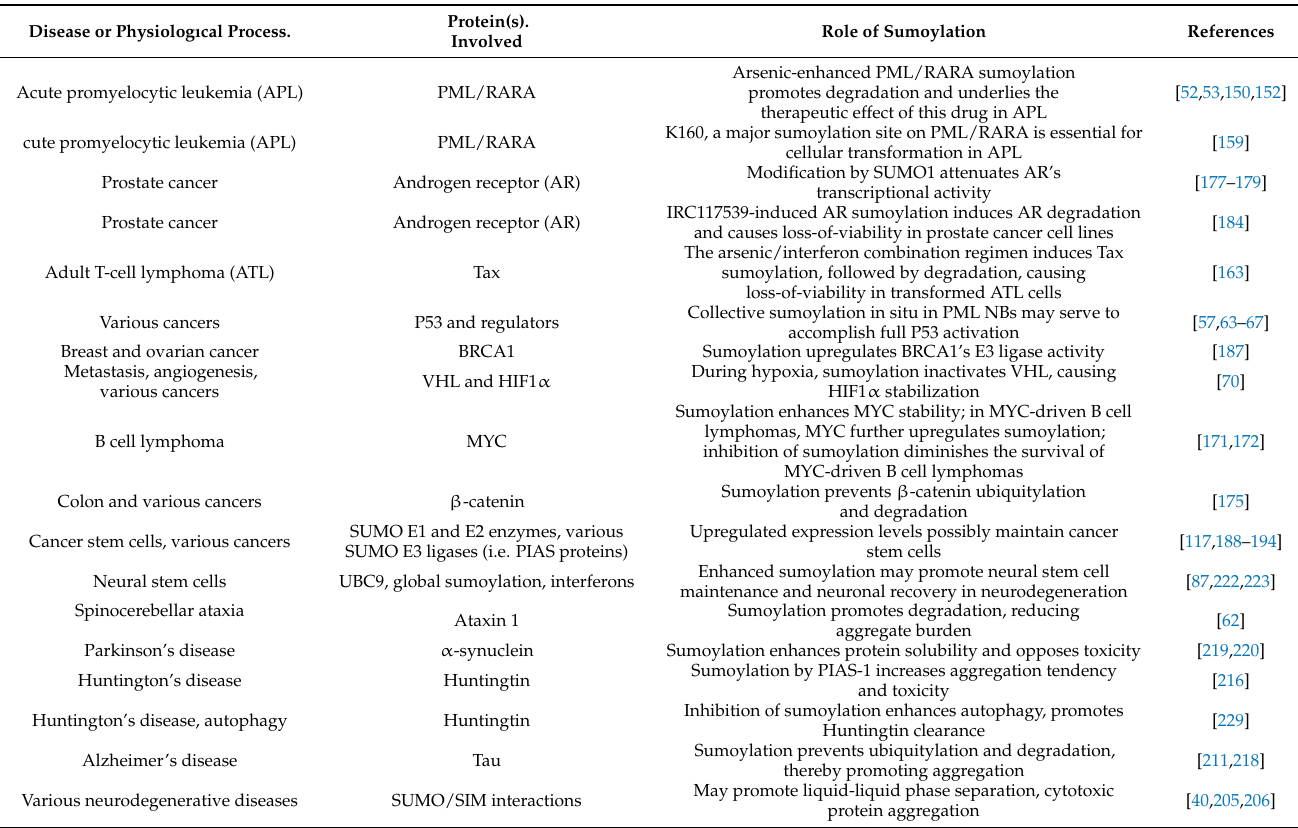
Table 1. Context- and substrate-dependent roles of sumoylation in cancer and neurodegeneration. Depending on the modified target protein, sumoylation may play a detrimental or beneficial role, both in the pathology and therapy of various